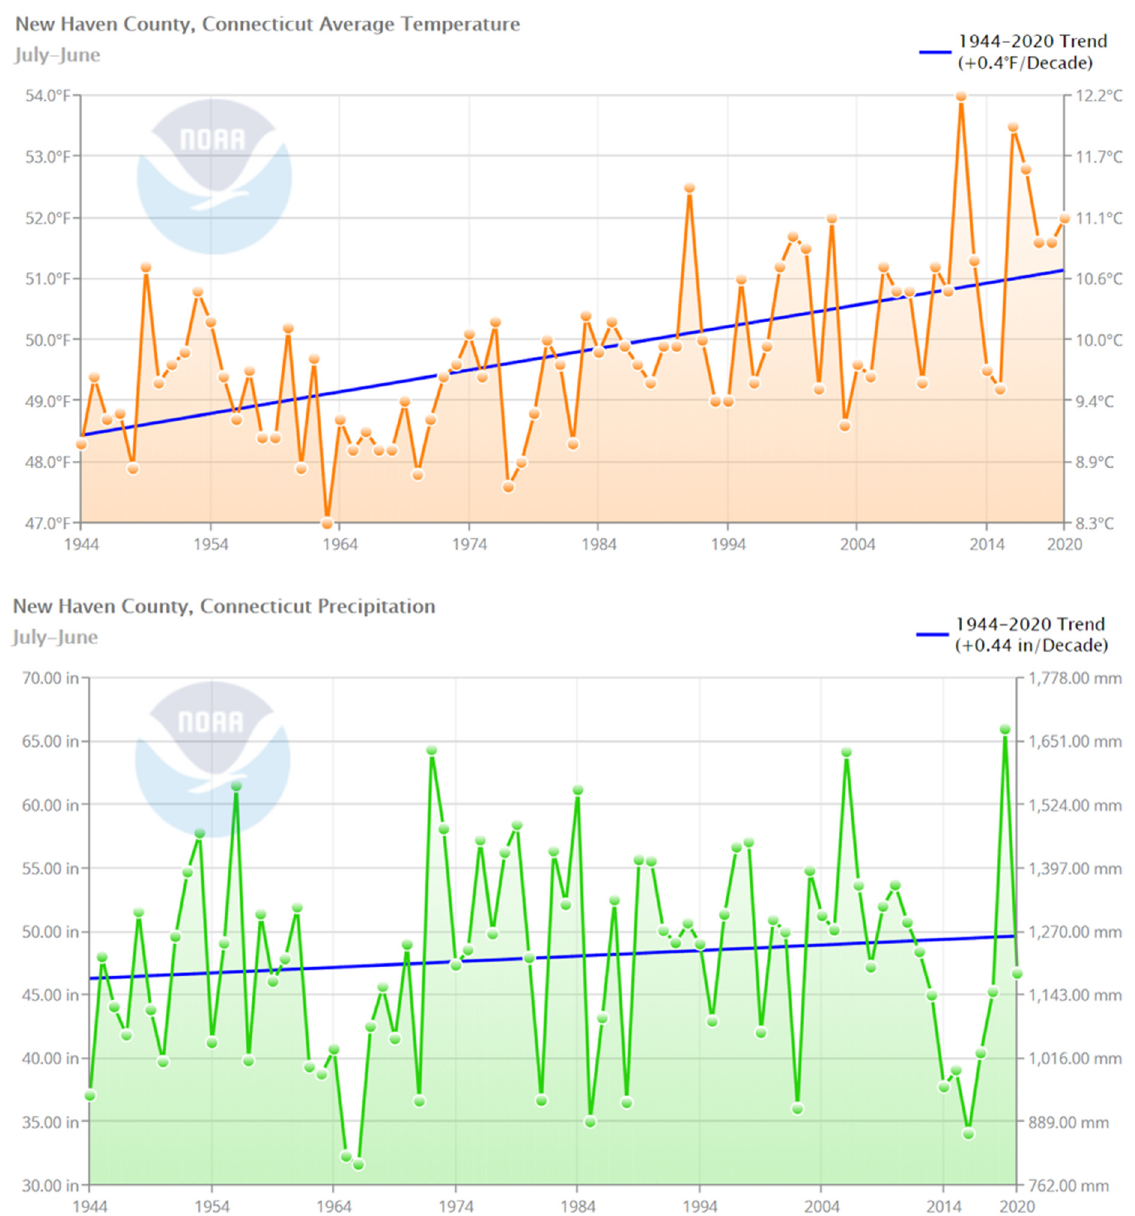
Figure 7. Average temperature ( a ) and precipitation ( b ) in New Haven County, Connecticut, from 1944 to 2020 (NOAA).